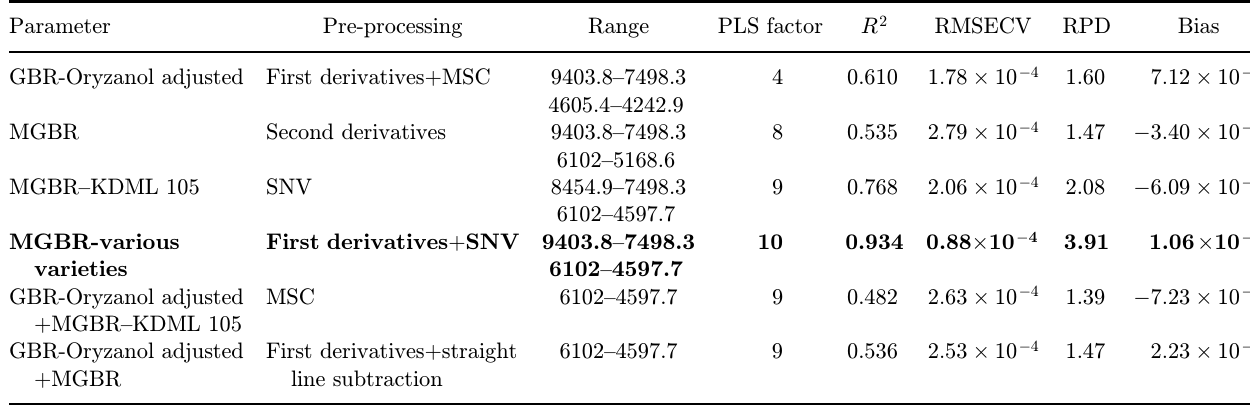
Table 2. Statistics of prediction of gamma oryzanol content of GBR by PLS models.